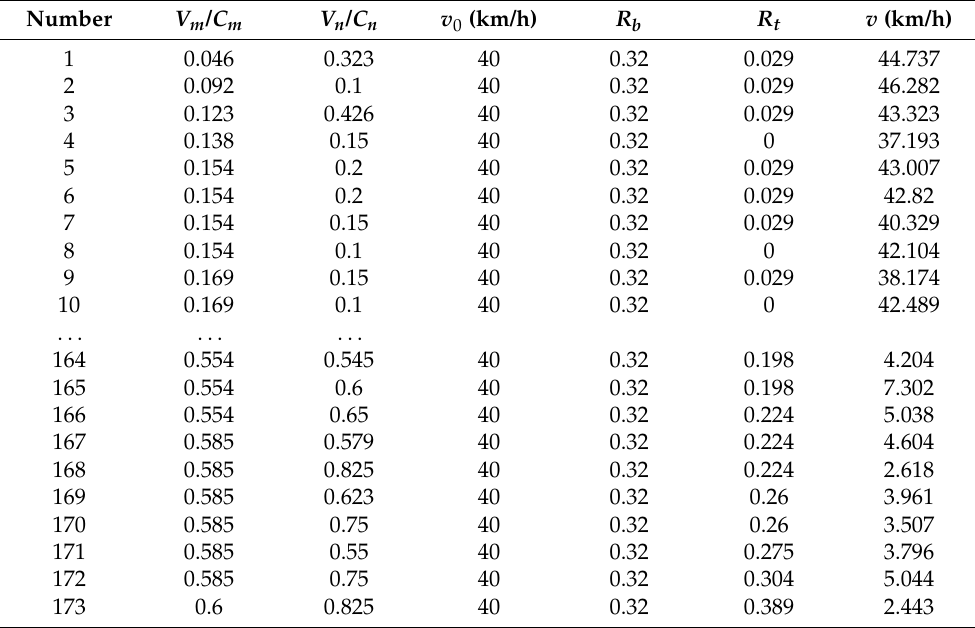
Table A2. BPR model parameters during roadside parking in scenario A (example).